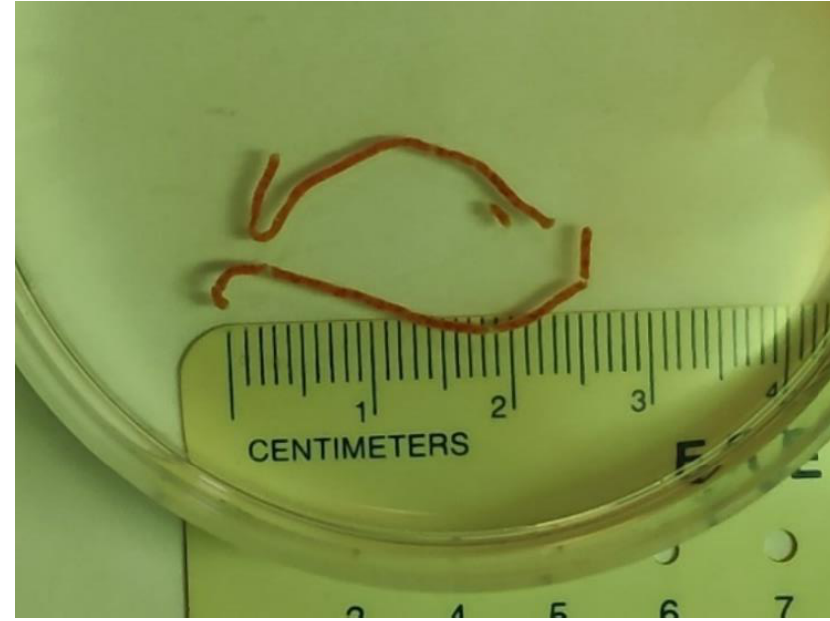
Figure 1. Two visible liver core specimens following EUS-LB.